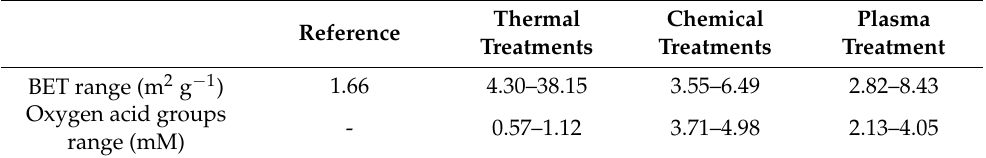
Table 4. Comparison range of treatment methods considering the surface area and oxy- genated